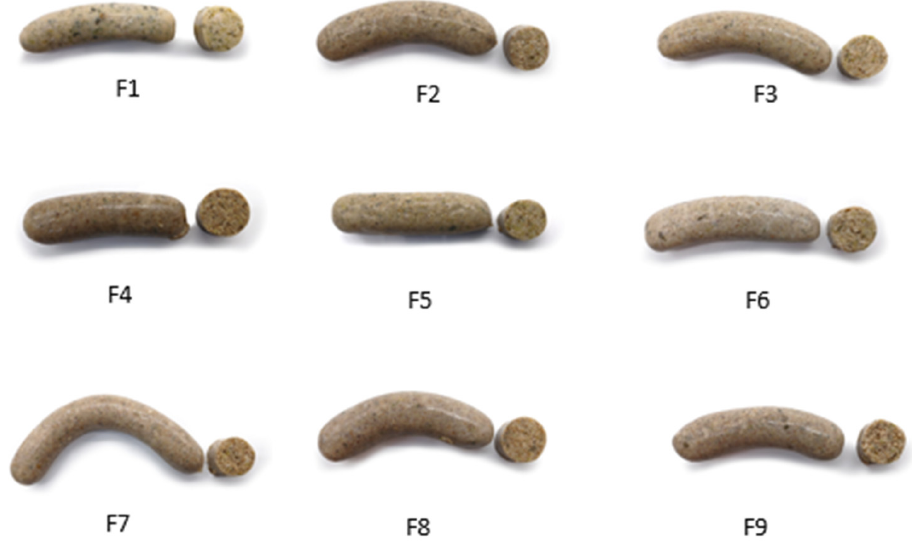
Figure 2. Images of the 9 hybrid sausages used in the experiments. The samples, labelled from F1 to F9, contain different percentages of broccoli, upcycled brewer’s spent grain and insect flour (BR, BSG, IF): F1 (35, 0, 0), F2 (30, 5, 0), F3 (25, 0, 1), F4 (20, 5, 10), F5 (30, 0, 5), F6 (32, 3, 0), F7 (25, 5, 5), F8 (22, 3, 10) and F9 (27, 3, 5).